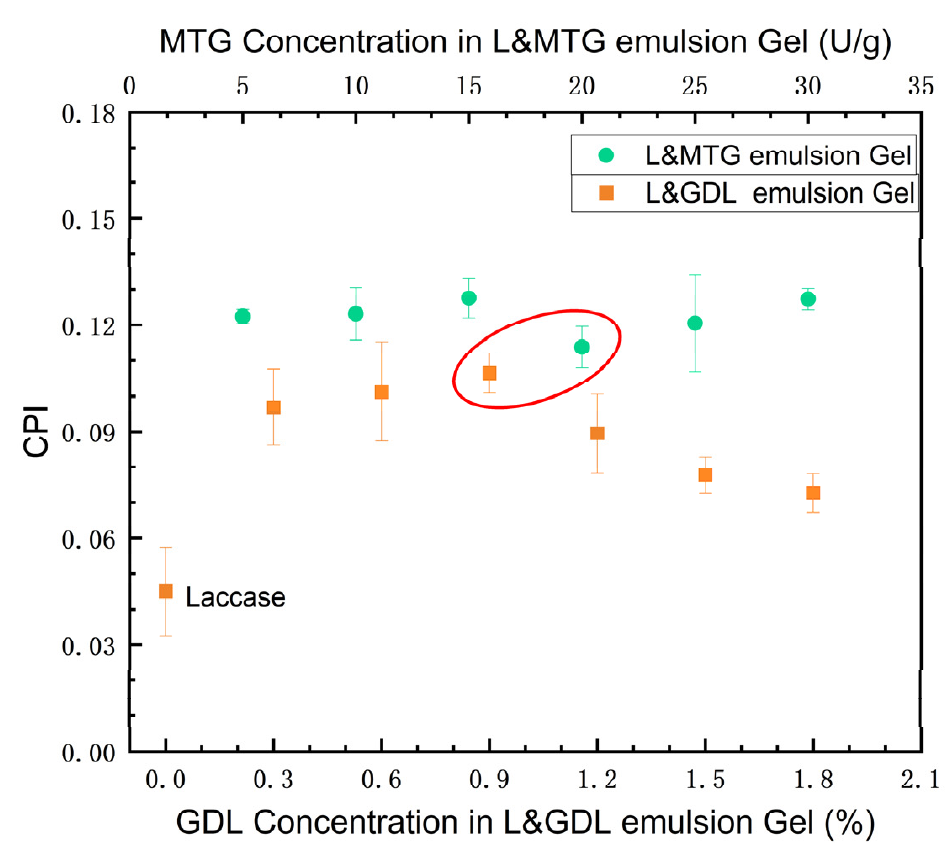
Figure 2. The CPI of SPI-SBP emulsion gels induced by laccase, L&GDL, and L&MTG. The plots of gels induced by laccase (0% GDL) and L&GDL were marked orange square ( (cid:4) ) versus bottom X-axis, and the plots of gels induced by L&MTG were marked green circle ( • ) versus top X ‐ axis.